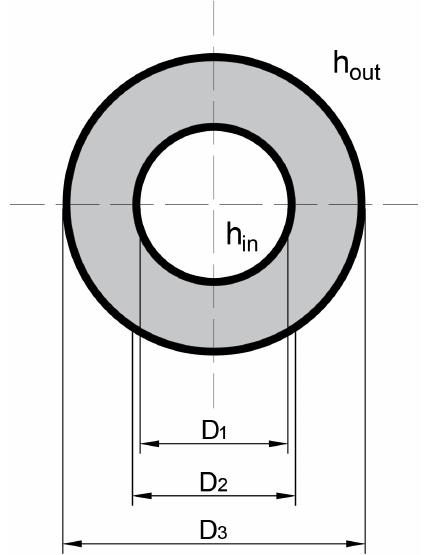
Figure 1. Cross-section of insulated pipe